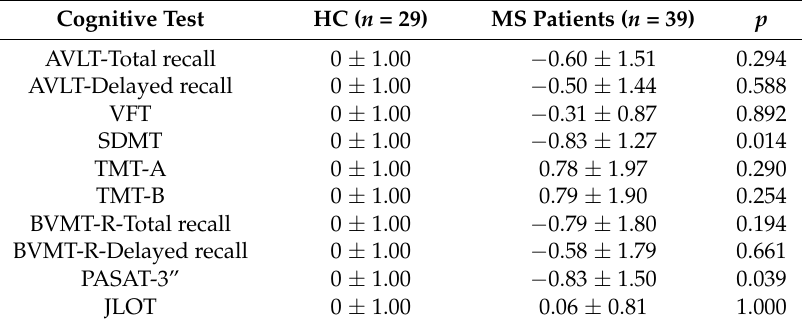
Table 1. Comparison of cognition between MS patients and HC.